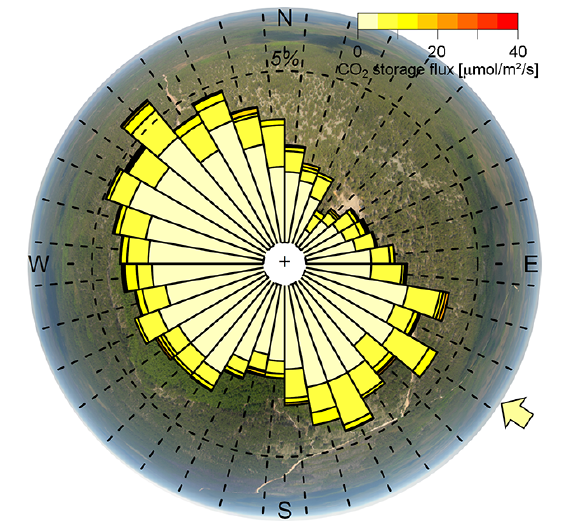
Fig. 6. Top view of ZOTTO centered on the tower with overlaid nighttime storage flux estimates (23:00 to 06:00, > 2µmol(m 2 s) − 1 only) vs. wind direction for all summer months June–September 2009–2011: the lengths of the petals show how often a flux from this direction was measured, colors indicate the strength of the storage flux and the arrow indicates the direction of the power